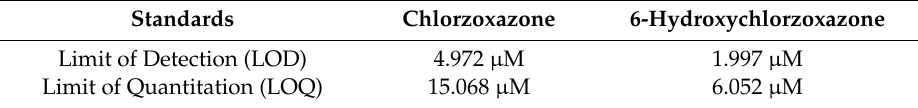
Table 2. LOD and LOQ for chlorzoxazone and 6-hydroxychlorzoxazone.